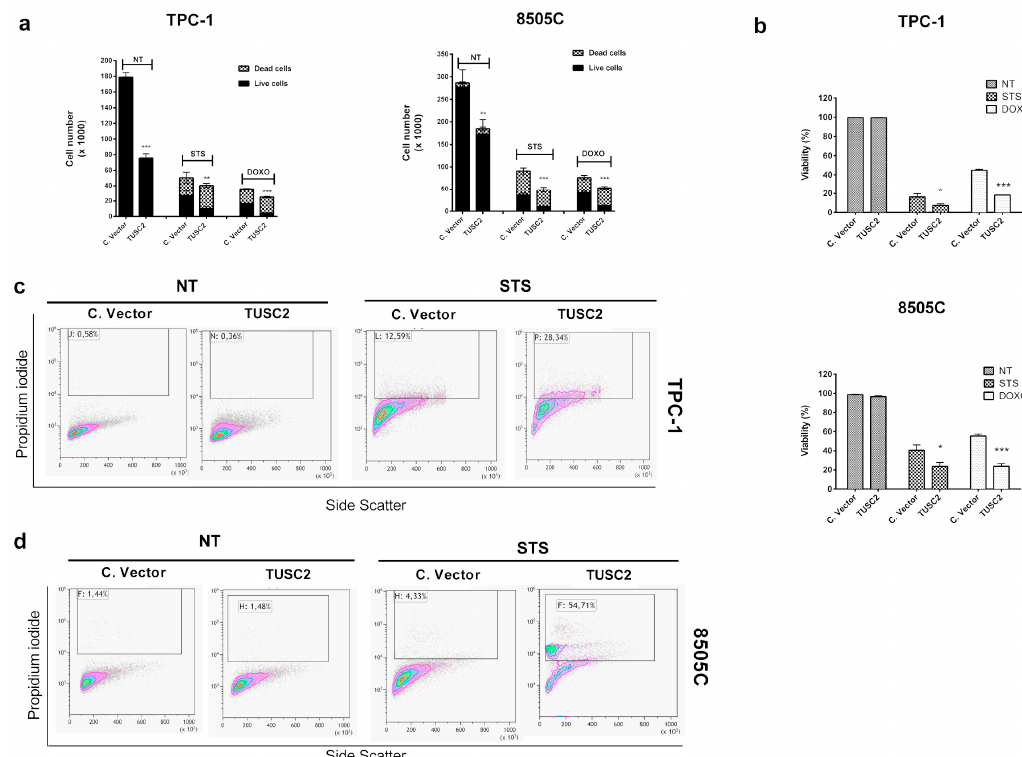
Figure 4. TUSC2 forced expression increased sensitivity to apoptosis induced by doxorubicin (DOXO) and staurosporine (STS) in thyroid cancer cells. 8505C and TPC-1 cells stably transfected with TUSC2 or Control Vector plasmids were treated with 1 µM of doxorubicin (DOXO) or 2.5 µM of staurosporine (STS). After 48 (for DOXO) and 24 h (for STS), cells were collected by trypsinization, stained for 10 min with trypan blue and counted in triplicate. Histograms show the number of live and dead cells ( a ) and the percentage of cell viability ( b ) ± standard errors. Stably-transfected TPC-1 ( c ) and 8505C ( d ) cells were treated with 2.5 µM of STS for 6 h and the percentage of apoptotic cells was measured by flow cytometry with propidium iodide (PI) staining. Asterisks indicate * p < 0.05, ** p < 0.01 and *** p < 0.001 .